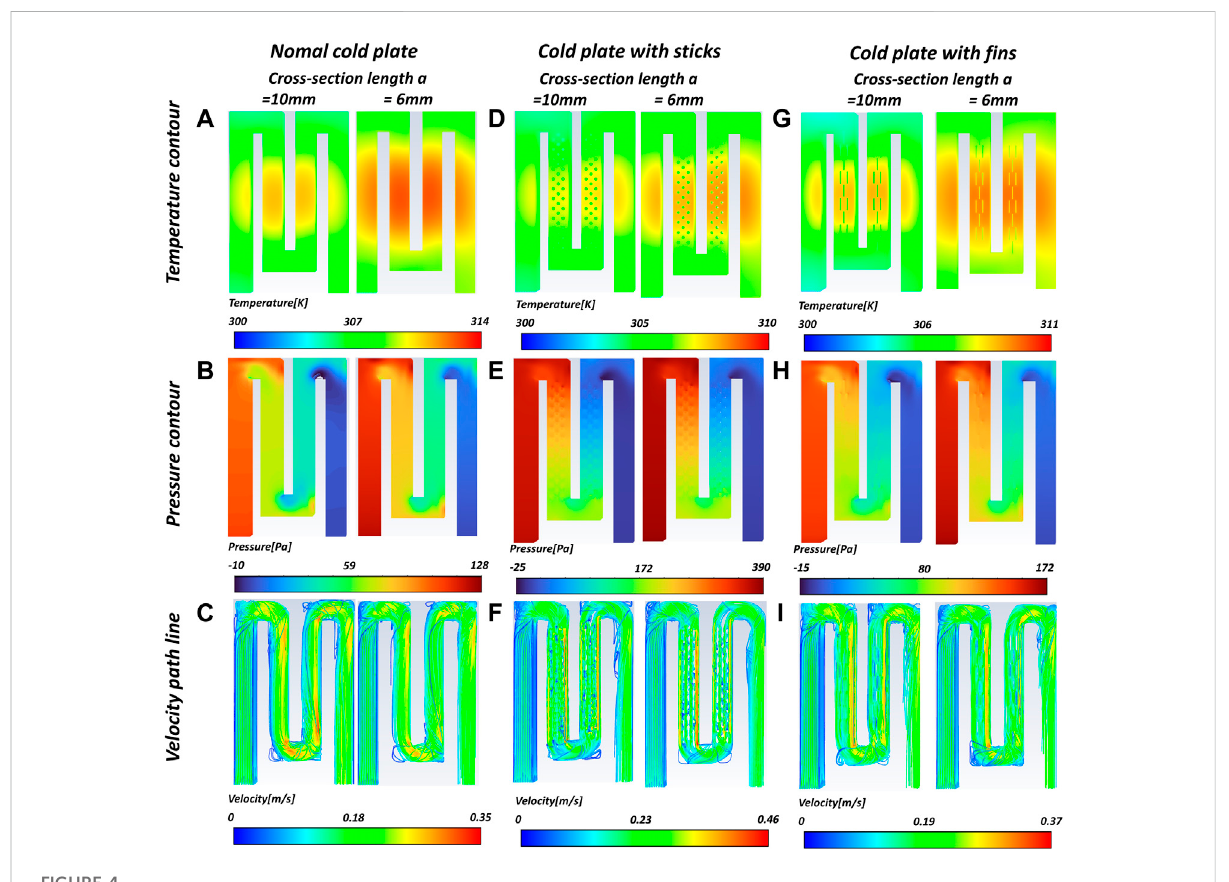
structure. However, the overall temperature of the fi nless cold plate is maintained at a higher level compared with the latter two structures. It shows that the cold plate without fi n structure has a weak capacity for heat transfer. Figure 5B shows that in the fl ow channel of the gang structure, the fl ow traces are greatly in fl uenced by the internal structure, and the traces go around the sides of the bars while showing a wavy pattern between the bars. The maximum of velocity appears on both sides of the channel. It can be seen that the fl ow channel with rods greatly affects the fl ow of coolant. The fl ow resistance in the fl ow channel is increased. And the velocity of fl ow between the rods arranged in front and back along the fl ow direction is small, losing most of the heat transfer. As can be seen in Figure 5C, the temperature of the cold plate is maintained at the same level as the rod